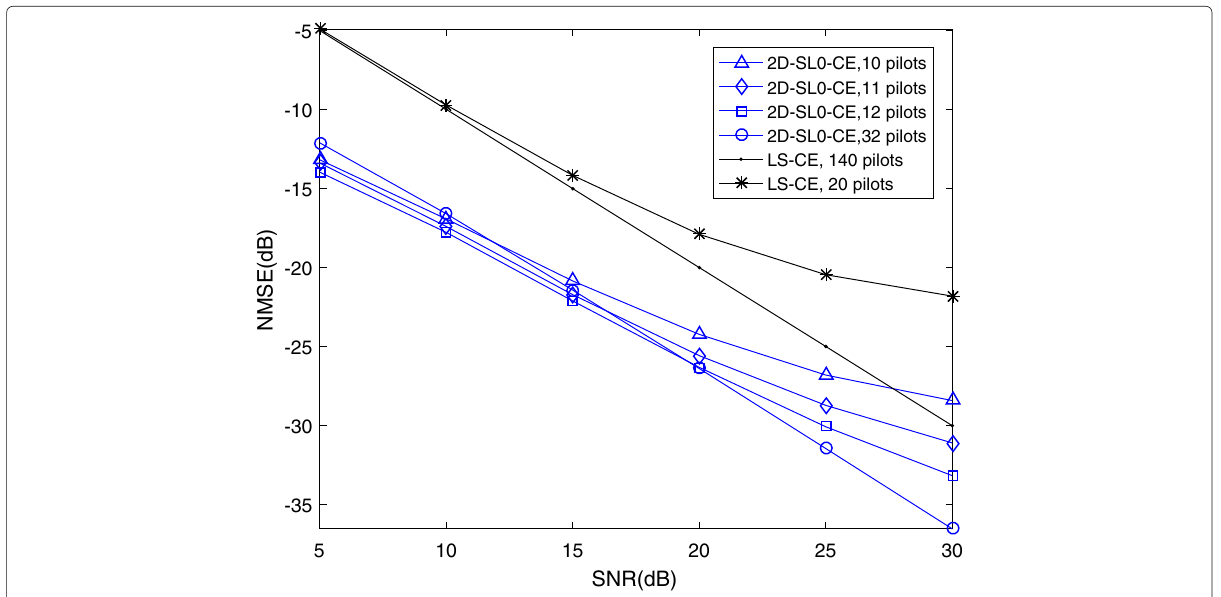
Fig. 1 NMSE performance of 2D-SL0-CE and LS